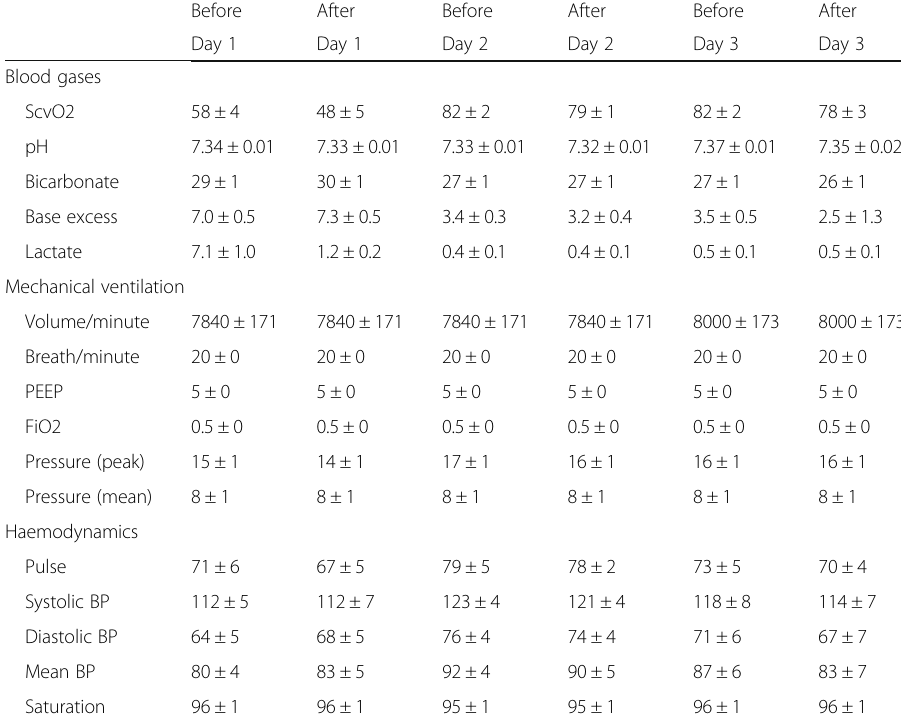
Table 3 Hemodynamics parameters before and after recruitement manoeuvres (RM) during the daily measurements Before After Before After Before